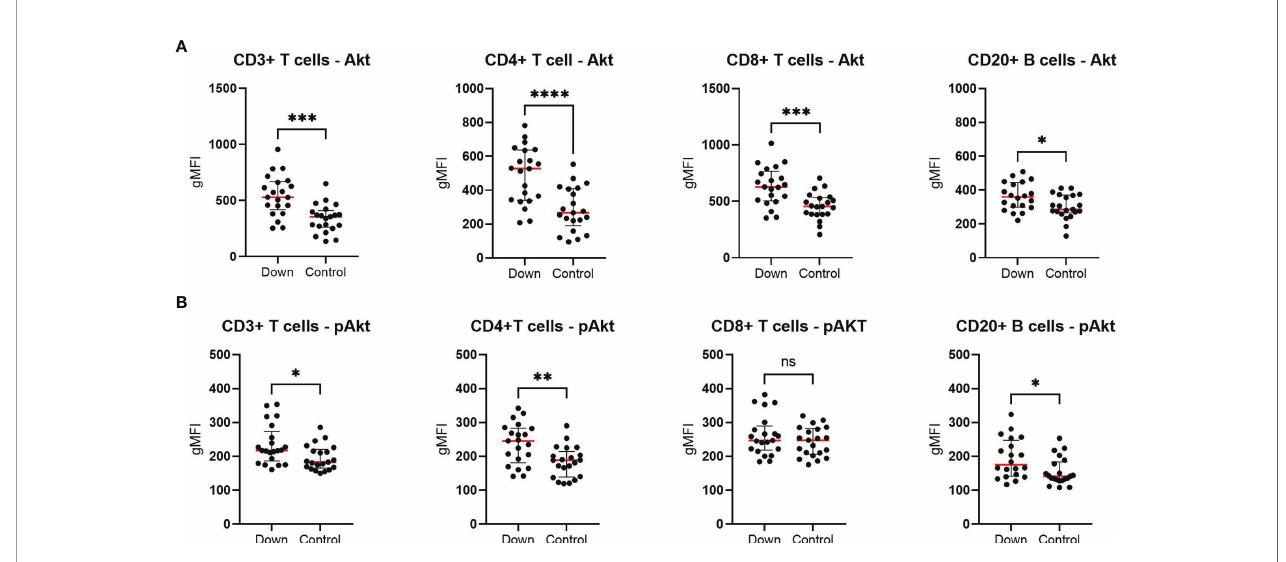
FIGURE 4 | Phospho- fl ow analysis in 21 children with Down syndrome and 21 healthy age-matched controls. (A) The total AKT levels were elevated in all different cells for children with Down syndrome. (B) In children with Down syndrome, pAKT levels were increased in CD3+, CD4+ and CD20+ cells, but not in CD8+ T cells. Median and interquartile ranges are indicated. *p < 0.05; **p < 0.01; ***p < 0.001; ****p < 0.0001; ns p > 0.05.